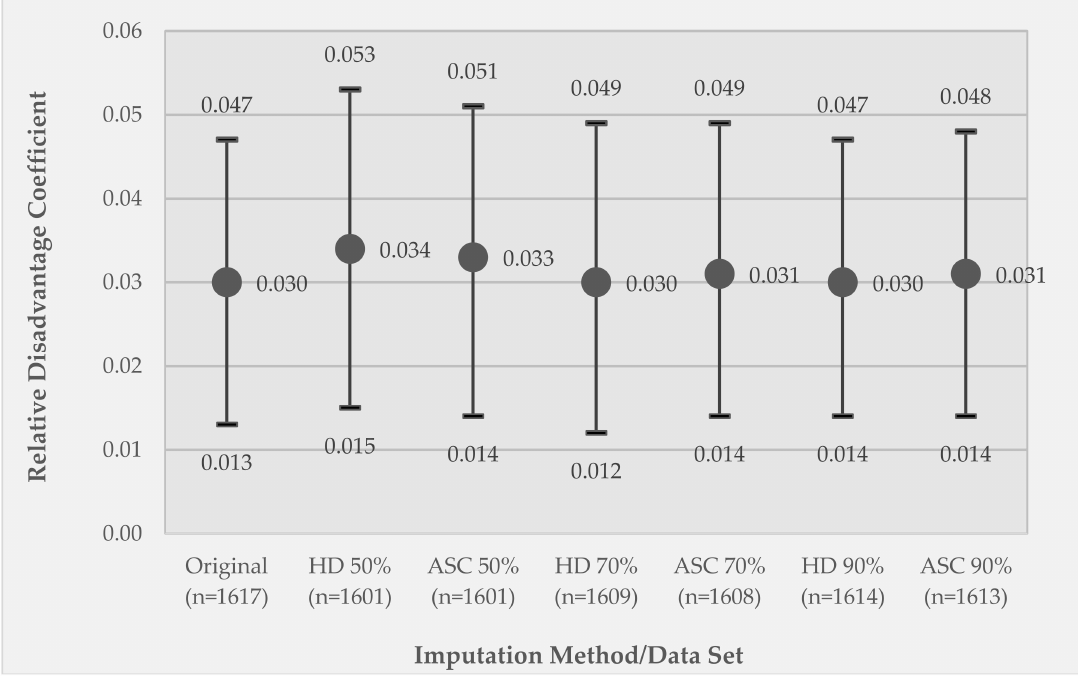
Figure 4. Results for the imputed data sets for Model 1, GEE coefficients of the effect of relative disadvantage on momentary stress. Coefficients are reported for the original data set (100% retained) and for each imputation technique (hot deck (HD) or activity space centroid (ASC)) applied to different percentages of the retained observations (50% retained (50% imputed), 70% retained (30% imputed), and 90% retained (10% imputed)). Circle markers represent coefficient values; whiskers represent 95% confidence intervals. All coefficients are significant at p <